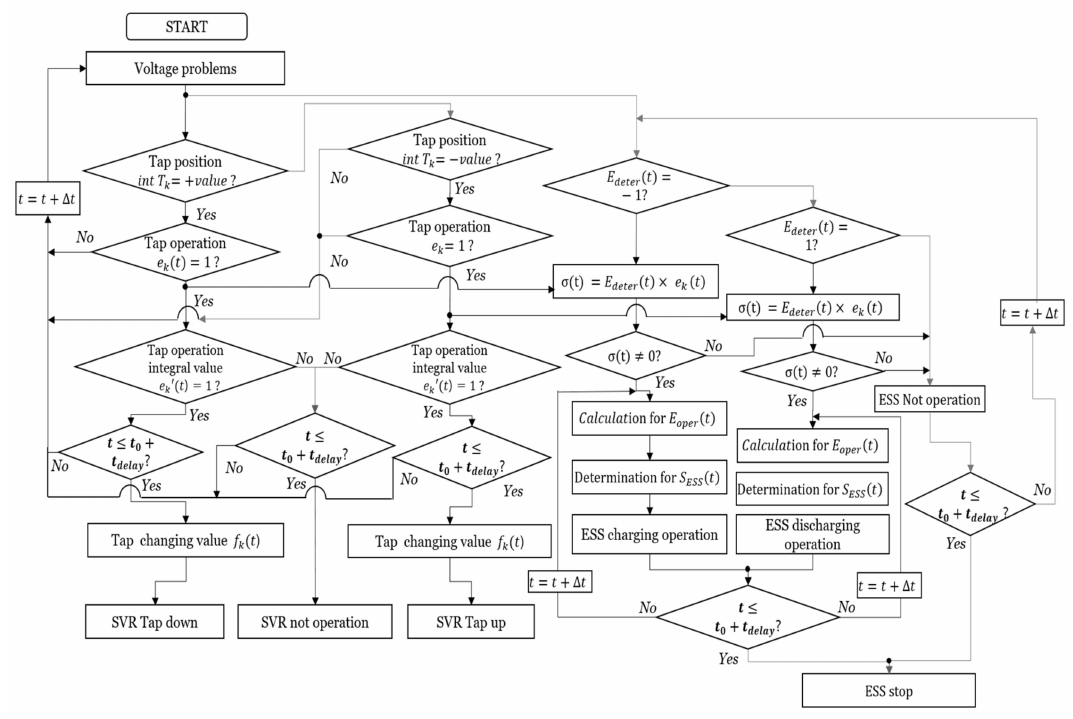
Figure 13. Voltage control algorithm by SVR and ESS.